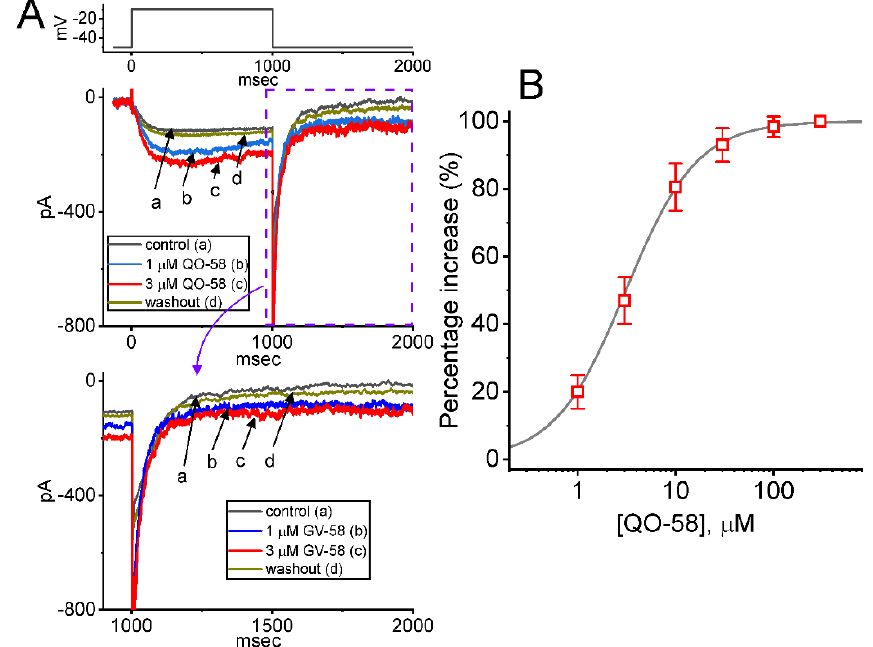
Figure 1. QO-58-induced stimulation of M-type K + current ( I K(M) ) recorded from pituitary GH 3 cells. In these experiments, we placed cells in high-K + (145 mM), Ca 2+ -free solution that contained 1 µ M tetrodotoxin (TTX) and 0.5 mM CdCl 2 and the electrodes that we used were filled up with a K + -containing solution. ( A ) Superimposed current traces obtained in the control period (a), during cell exposure of 1 µ M QO-58 (b) or 3 µ M QO-58 (c), and washout of QO-58 (d). The top part indicates the voltage-clamp protocol applied, while the lower part is an expanded record from purple dash box in the upper part. ( B ) Concentration-dependent stimulation of QO-58 effect on the amplitude of I K(M) (mean ± SEM; n = 8 for each point). Current amplitudes during cell exposure to different QO-58 concentrations were measured at the end of depolarizing pulse from − 50 to − 10 mV with a duration of 1 s. Sigmoid smooth curve indicates best fit to a modified Hill function described in Section 4.